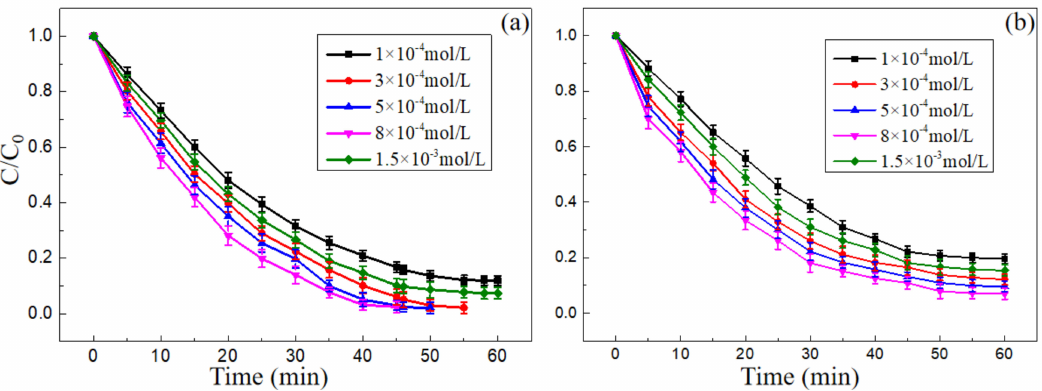
Figure 7. Effect of spatial structure of nano-PAA-CuCl 2 catalyst on the degradation, ( a ) MB and ( b ) MO. Experimental conditions: initial H 2 O 2 concentration 18 mM for MB and 23 mM for MO, initial pH value of 3, 30 ◦